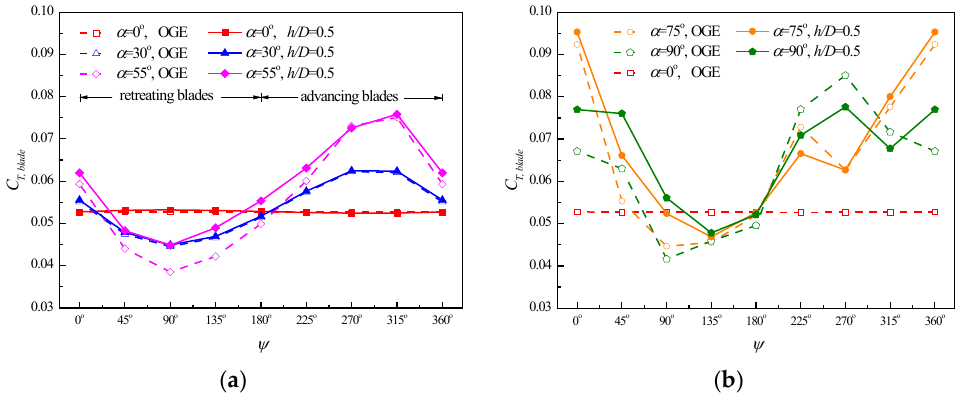
Figure 25. Thrust coefficient of blades at different azimuths at J = 0.5: ( a ) before stall; ( b ) after stall. After the stall occurs, the flow separation extends to the entire duct lip on the wind- ward side. Taking the case of α = 90° as an example, Figure 26 shows the axial velocity contours on the cross sections passing through and intersecting the blade rotating plane. Negative values of the axial velocity indicate that the flow direction is locally reversed, as shown in the areas outside the black lines in Figure 26a and within the red dotted line in Figure 26b. The flow separation on the duct lip leads to a recirculation region across the rotor plane. When the blade rotates through this region, its outboard part will see an up- wash resulting from the recirculation. The upwash increases the effective angle of attack of the blade locally, and thus, the blade produces more thrust in this region, as shown in Figure 25b. The intensity and scope of the recirculation increase in the ground effect com- pared with those out of the ground effect. Under the combined effect of the separated flow and ground effect, the thrust of the advancing blades may decrease compared with the value out of the ground effect, but the total thrust of the blades still increases. It should be noted that given the complexity of the flow and the limitations of the MRF-based method, the upwash may not be the only reason for the increase in blade thrust after the stall oc- curs.